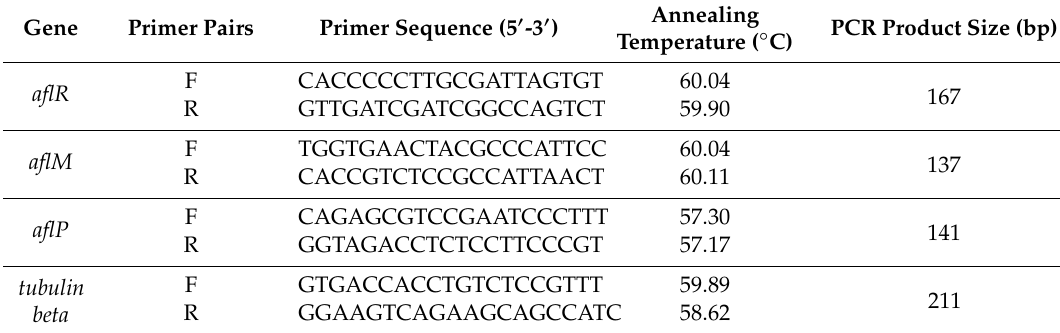
Table 4. The genes in the aflatoxin biosynthetic pathway and the